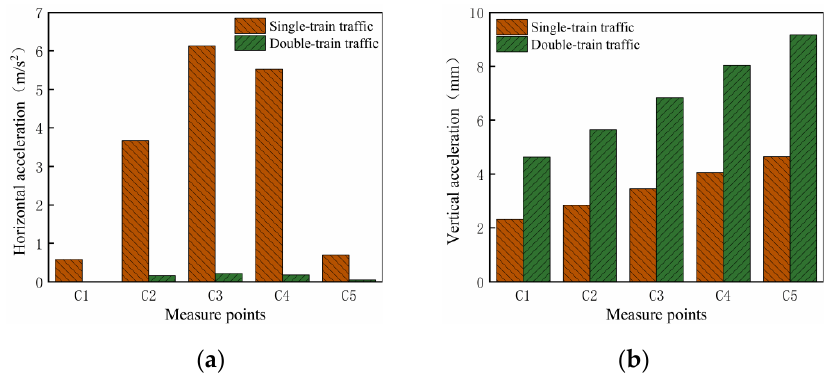
Figure 18. PPA of measuring point: ( a ) PPHA ; ( b ) PPVA .